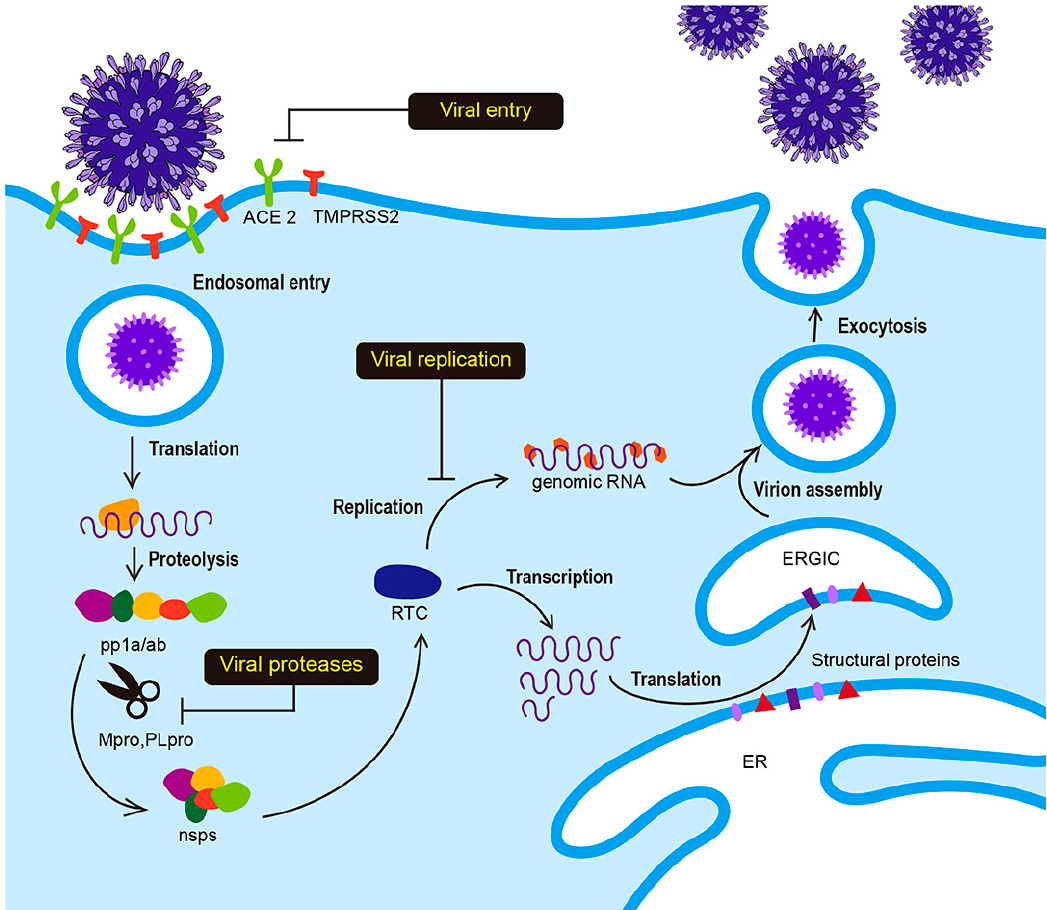
Figure 1. Life cycle of SARS-CoV-2 nonstructural proteins (RNA-dependent-RNA polymerase and hellicase) (nsps), replicase-transcriptase complex (RTC), endoplasmic reticulum (ER), nucleocapsid (N), ER-golgi intermediate compartment (ERGIC), co-terminal polyproteins (pp1a/ab). Angiotensin-converting enzyme (ACE 2). Reproduced with permission from Jeong, G.U.; Song, H.; Yoon, G.Y.; Kim, D.; Kwon, Y.-C., Frontiers in. Microbiology, published by frontiers, 2020 .[7].,